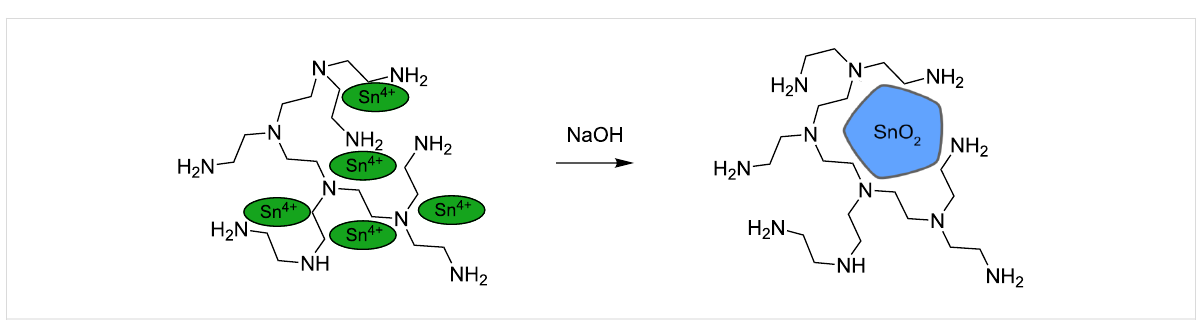
Figure 5: Schematic synthesis of polyethylenimine-stabilised SnO 2 nanoparticles.